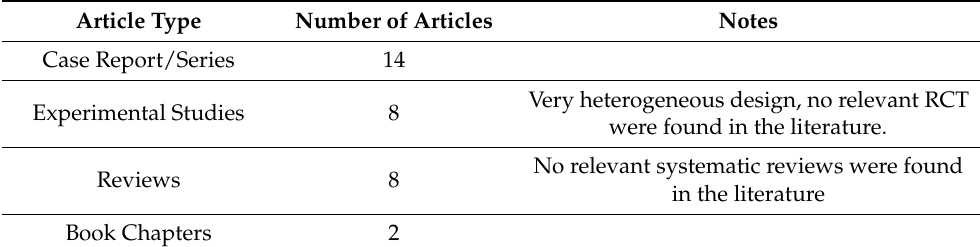
Table 1. Type of publications included in the final review.